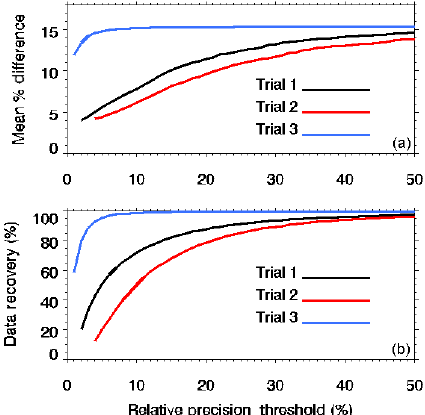
Figure 6. (a) Mean percent difference in wind speed between the CDL and the tower and (b) the data recovery as functions of the rel- ative precision threshold. The black, red and blue curves correspond to trials 1, 2 and 3